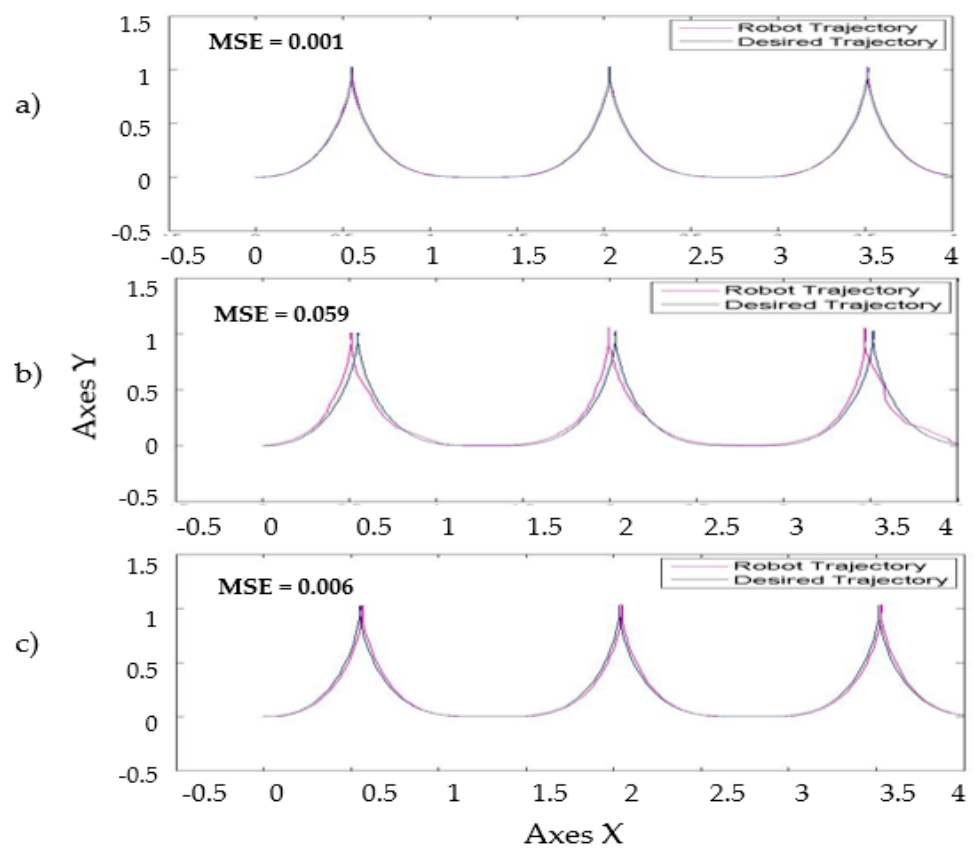
Figure 17. Trajectory in the autonomous mobile robot controller, ( a )Traditional BCO; ( b ) BCO algorithm applied perturbation called band-limited with value of 1; ( c ) BCO algorithm applied perturbation called pulse generator with value of 1.